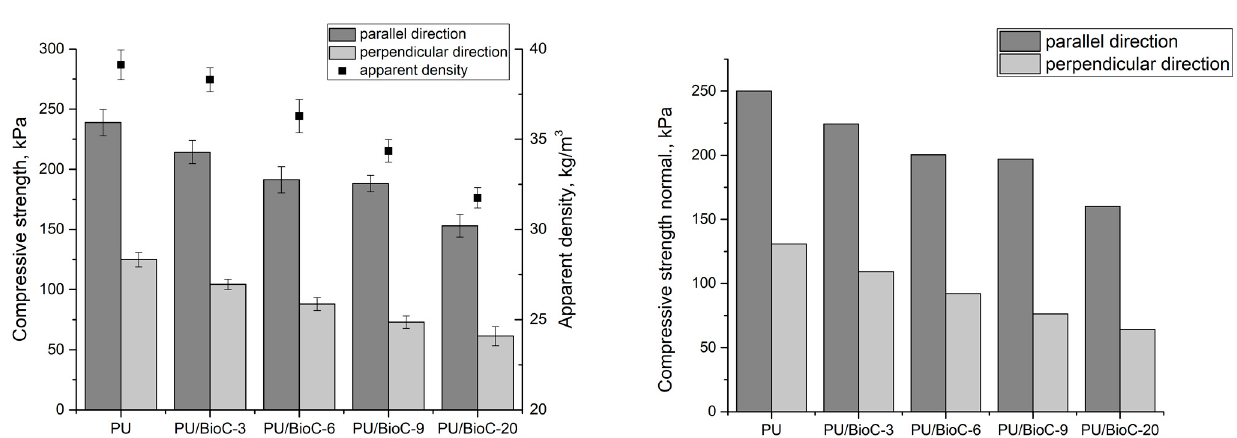
Figure 6. Compressive strength and normalized compressive strength of polyurethane foams.